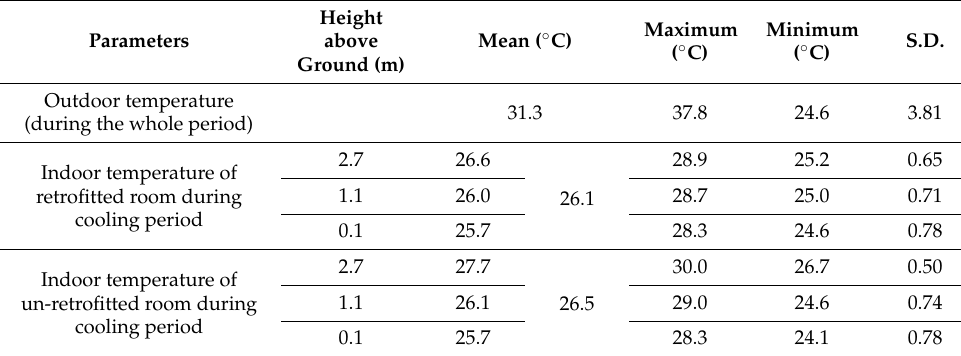
Table 4. Results of measured temperature data during the cooling period.